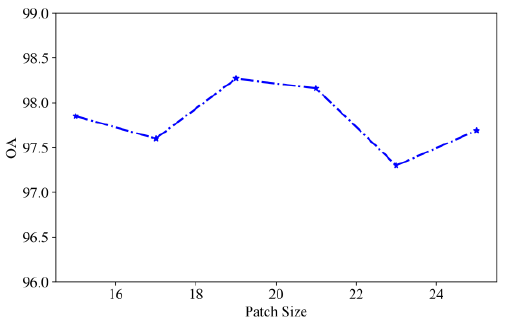
Figure. 4. Overall accuracy of DGCNet with change of patch size.